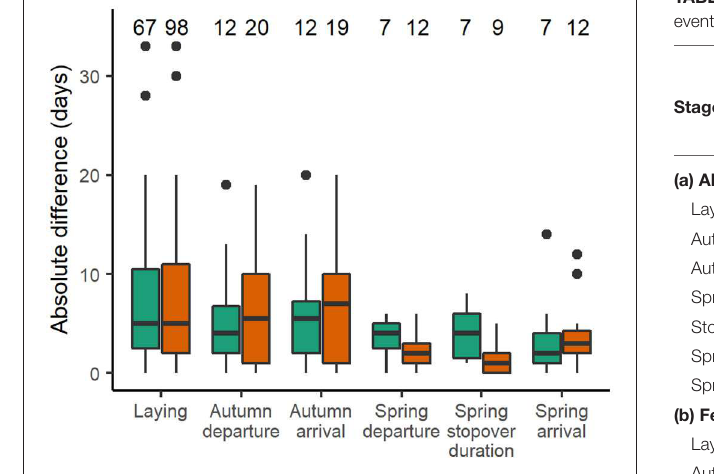
FIGURE 3 | Absolute interannual difference in timing for each annual stage, grouped by sex (females in green, males in orange); boxes show the median and 25 and 75% quartiles, whiskers extend up to 1.5 times the inter quartile range from the median and points beyond that are individually marked; the number above each boxplot shows the sample size.